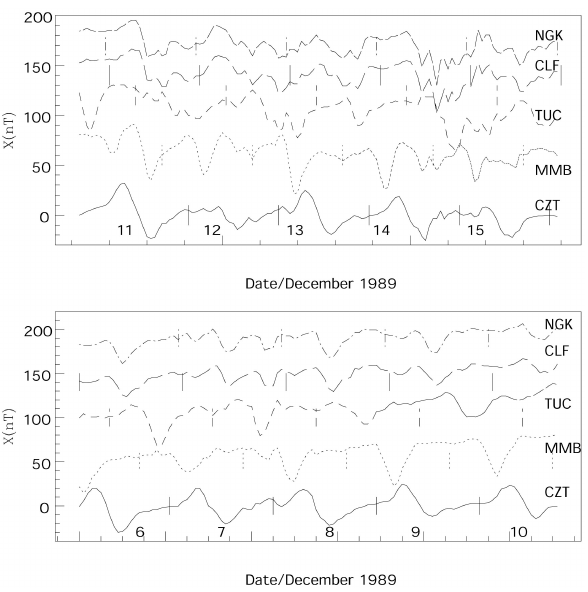
Fig. 8. A time series of X component hourly values from 6 to 15 December 1989 from a range of observatories: NGK (Niemegk) in Eastern Germany, CLF (Chambon la Forˆet) in France, TUC (Tuc- son) in Southern USA, MMB (Memambetsu) in Northern Japan and CZT (Port Alfred) in the Southern Indian